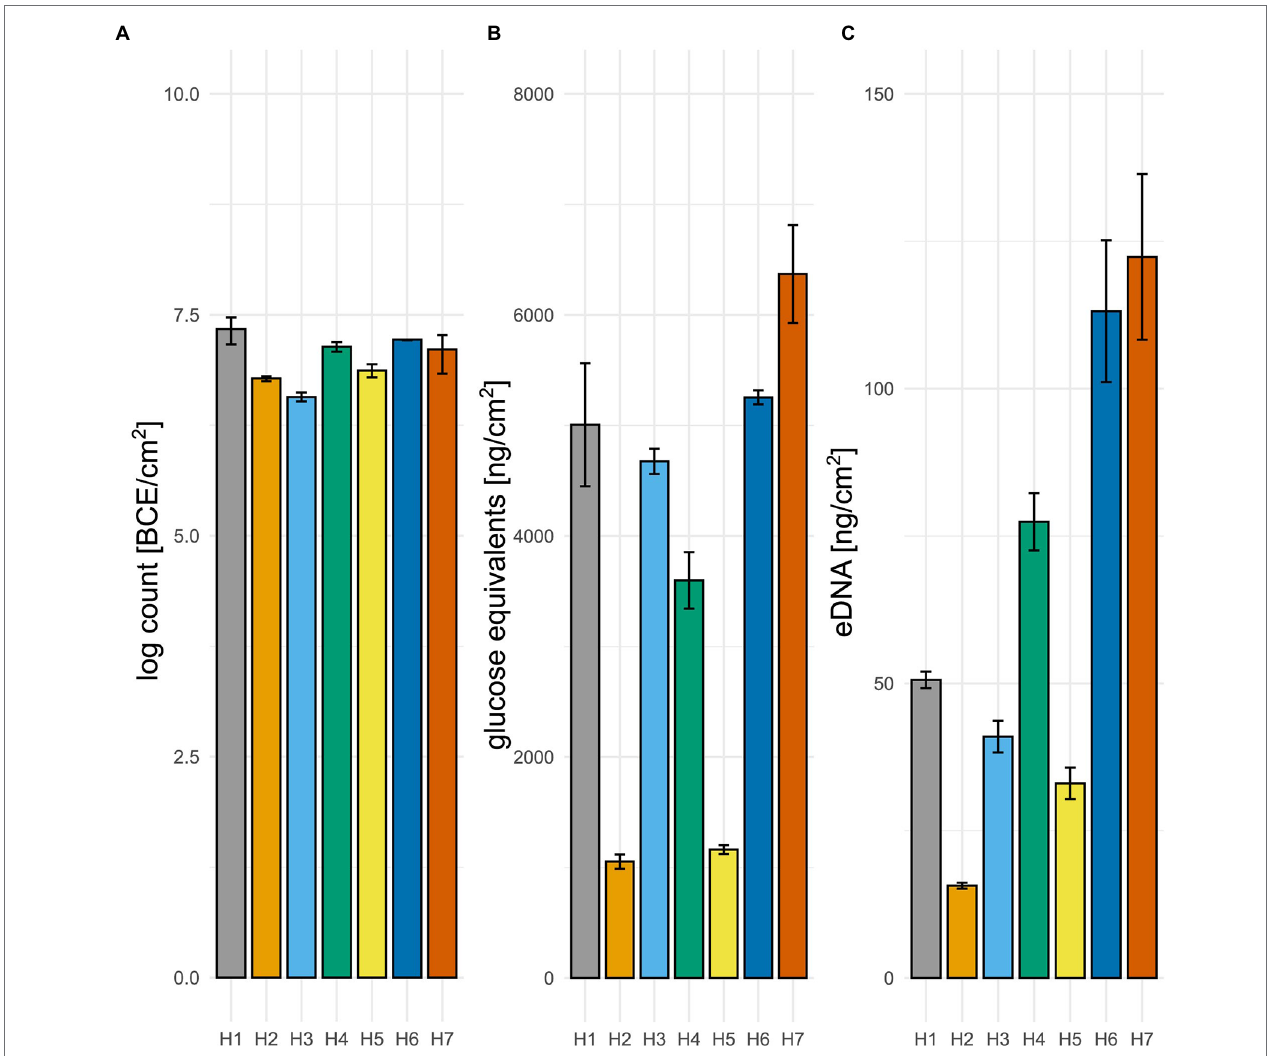
FIGURE 2 | Water hose biofilms. (A) Number of bacterial cell equivalents in biofilms was determined using a qPCR assay targeting the 16S rRNA gene. (B) Matrix polysaccharides were determined using a phenol-sulfuric acid method. (C) The amount of eDNA was spectroscopically measured. Mean values and standard deviation are given of at least two individual